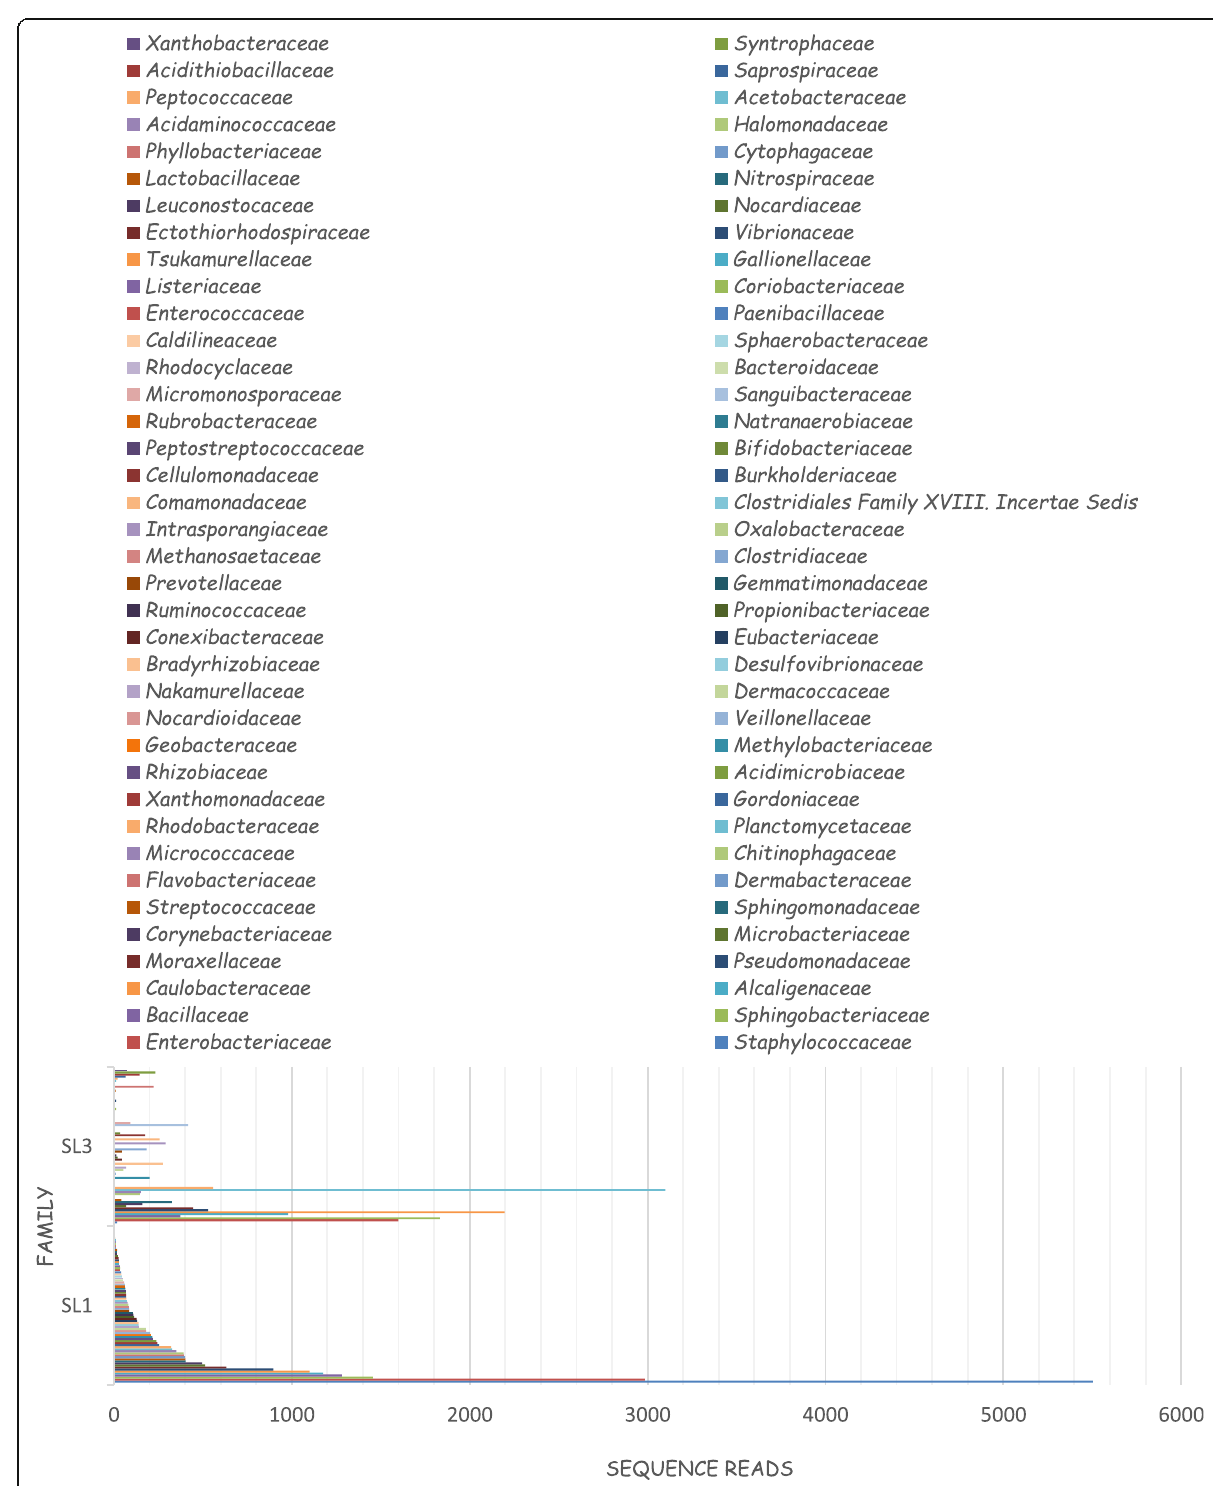
Fig. 4 Family classification of SL1 and SL3 metagenomes. Unclassified reads were not used. Only families with ≥ 10 sequence reads were used for the